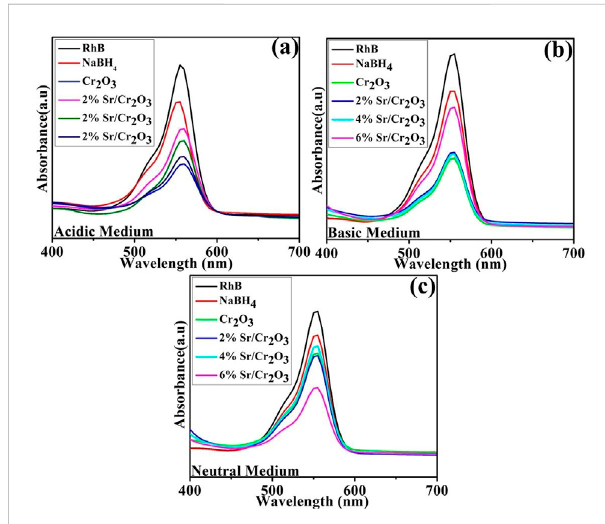
FIGURE 7 UV-Visible absorption spectra of RhB in the presence of